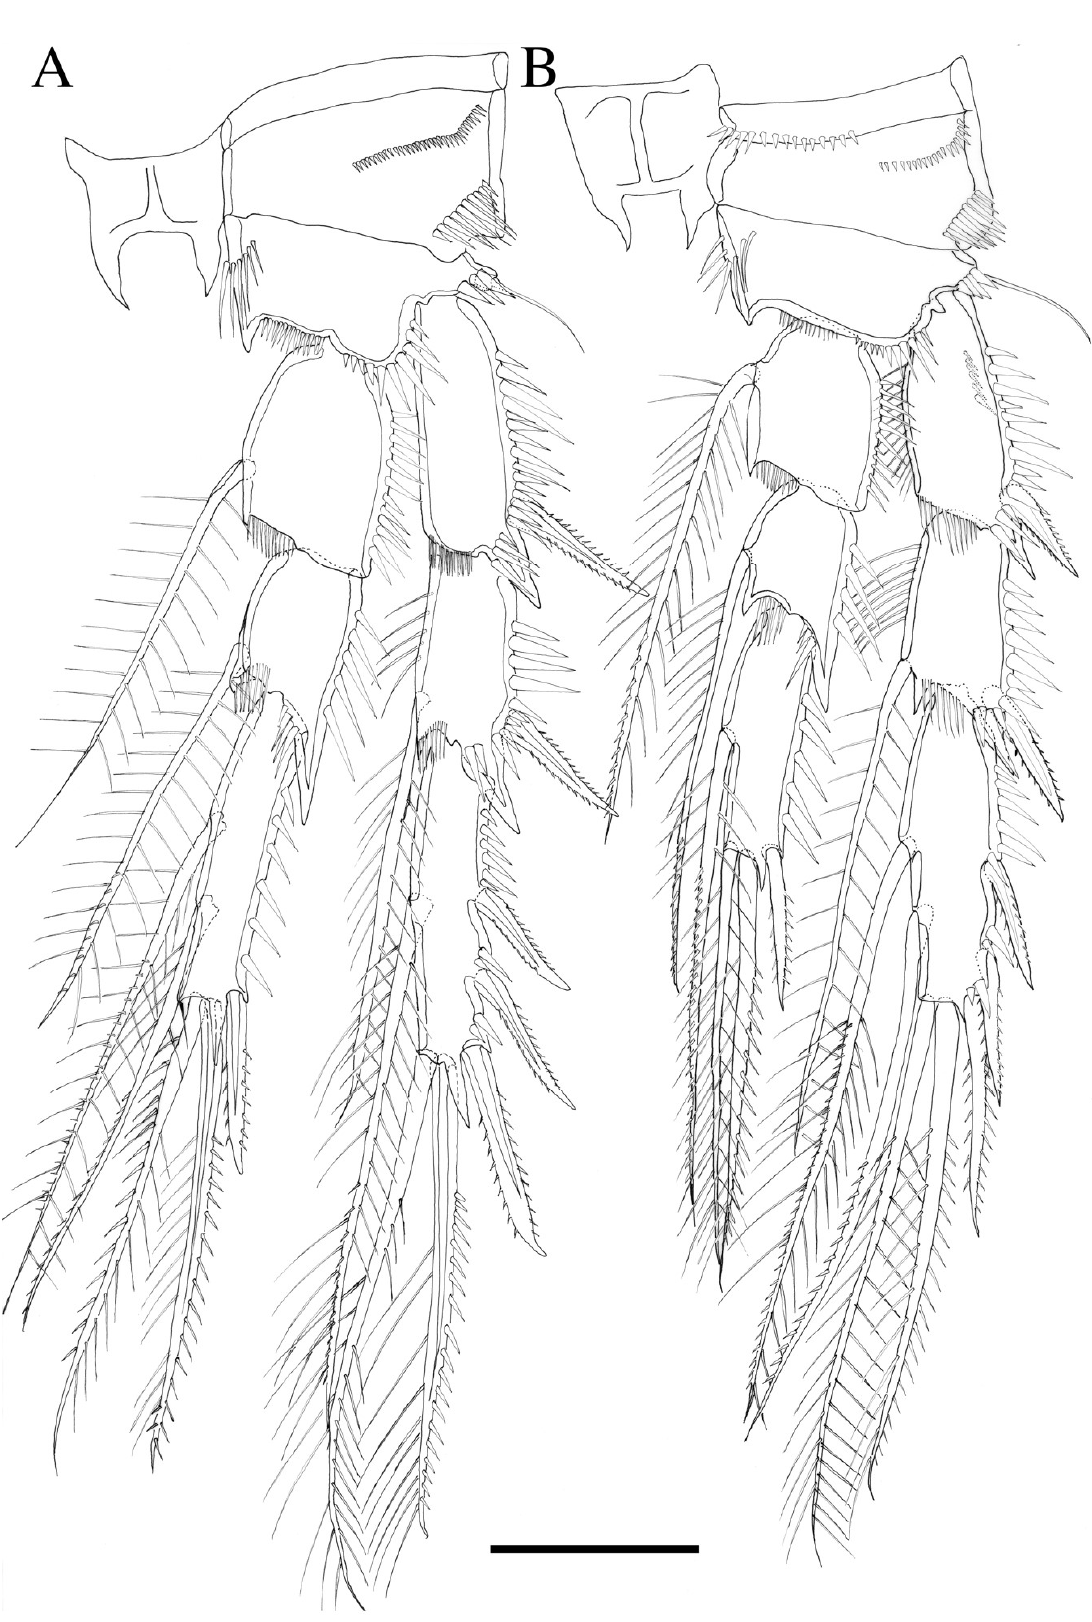
Figure 6. Robertgurneya jejuensis sp. nov. ( A ) P3. ( B ) P4. Scale bar: 50 μm.